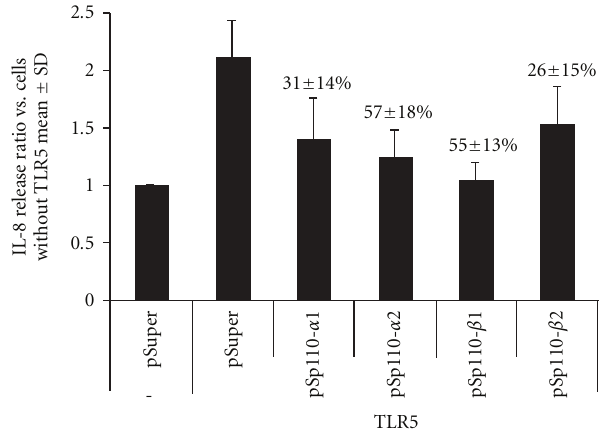
Figure 5: E ff ect of p110 α - and p110 β -targeted shRNA on IL- 8 production in TLR5-transfected, flagellin-stimulated HEK293T cells. Cells were transfected with TLR5 and a pSuper derivative or with pSuper alone and then stimulated with 500 ng/ml flagellin for 6 hours. IL-8 concentrations were determined by ELISA. pSp110- α 1 and - α 2 target 2 separate sites of p110 α , while pSp110- β 1 and - β 2 target two separate sites of p110 β . Results show fold increase versus baseline (IL-8 amounts measured in flagellin stimulated cells which were not transfected with TLR5). The percentages above the columns denote the amount of knockdown of either p110 α or p110 β mRNA as determined by quantitative RT-PCR; results were compiled from at least 7 samples from a minimum of 3 separate experiments. All four knockdowns significantly reduced IL-8 production ( P < . 001, ANOVA).